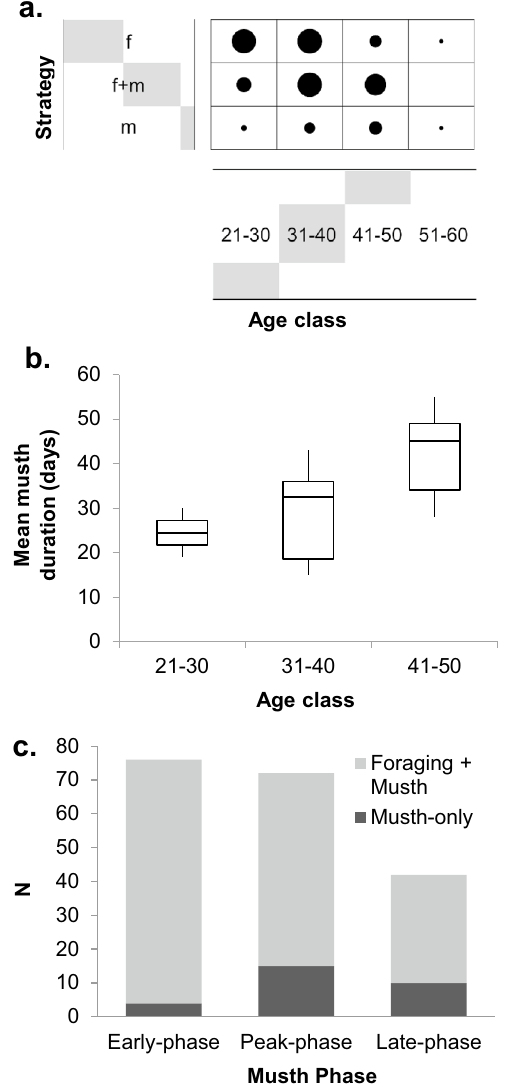
Figure 2. Musth expression and strategies. ( a ) Distribution of male ages across strategies (n = 216). The dot size reflects the relative number of males across age classes and musth categories. Grey bars are proportional to the total number of individuals observed in each row or column. Age class and strategy were significantly associated (Fisher’s exact test p < 0.0001). ( b ) Musth duration by age class. ( c ) Observed musth stages for males that were seen only in musth (n = 23), or those seen in both musth and foraging states (n = 99). More males are seen in the early phase than the peak or late phases, with the latter phases exhibited by more musth-only